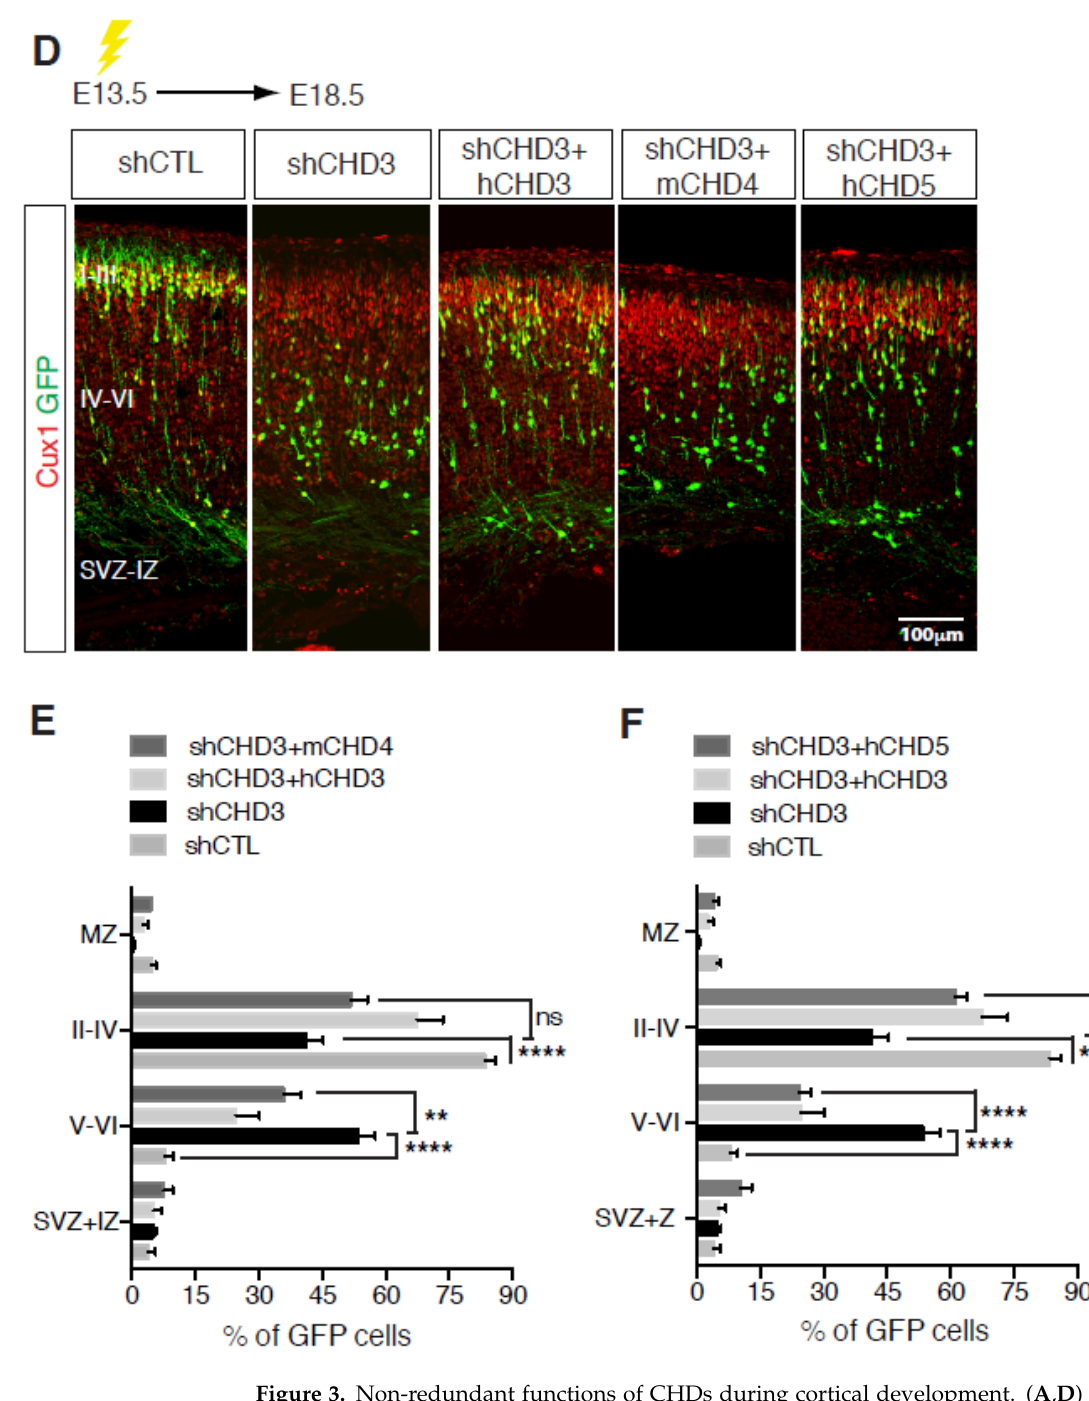
Figure 3. Non-redundant functions of CHDs during cortical development. ( A , D ) E13.5 embryos were electroporated with the indicated vectors and immunolabelled with GFP (green) and Cux1 (red) antibodies at E18.5. Scale bar, 100 µ m. ( B , C , E , F ) Distribution of cells electroporated with the indicated vectors at E13.5 and analysed at E18.5. 8–13 embryos were analysed per condition; n = 3. All data are presented as mean ± SEM. ** p < 0.01, and **** p < 0.0001 (ns, not significant) by two-way ANOVA with Tukey’s multiple comparisons test. Data published in [14].